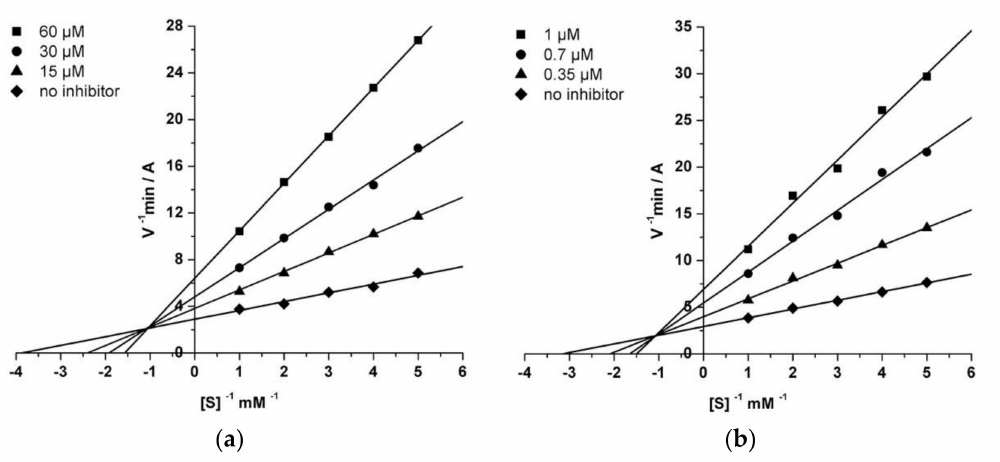
Figure 2. Kinetics of the steady-state inhibition of AChE ( a ) and BChE ( b ) by compound 4c . The data are presented as Lineweaver–Burk double-reciprocal